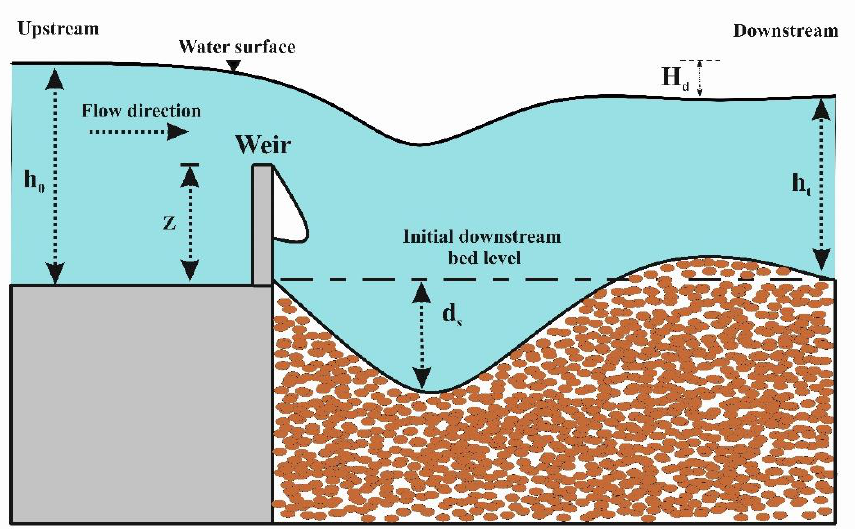
Figure 1. Sketch of the scouring process downstream of a weir.